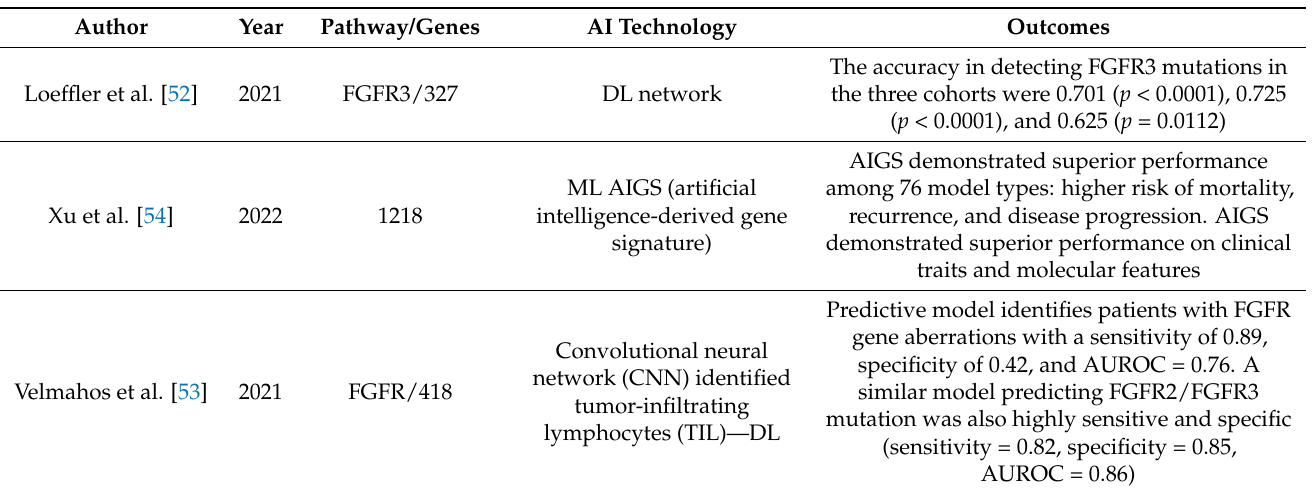
Table 4. Artificial intelligence technologies applied to molecular